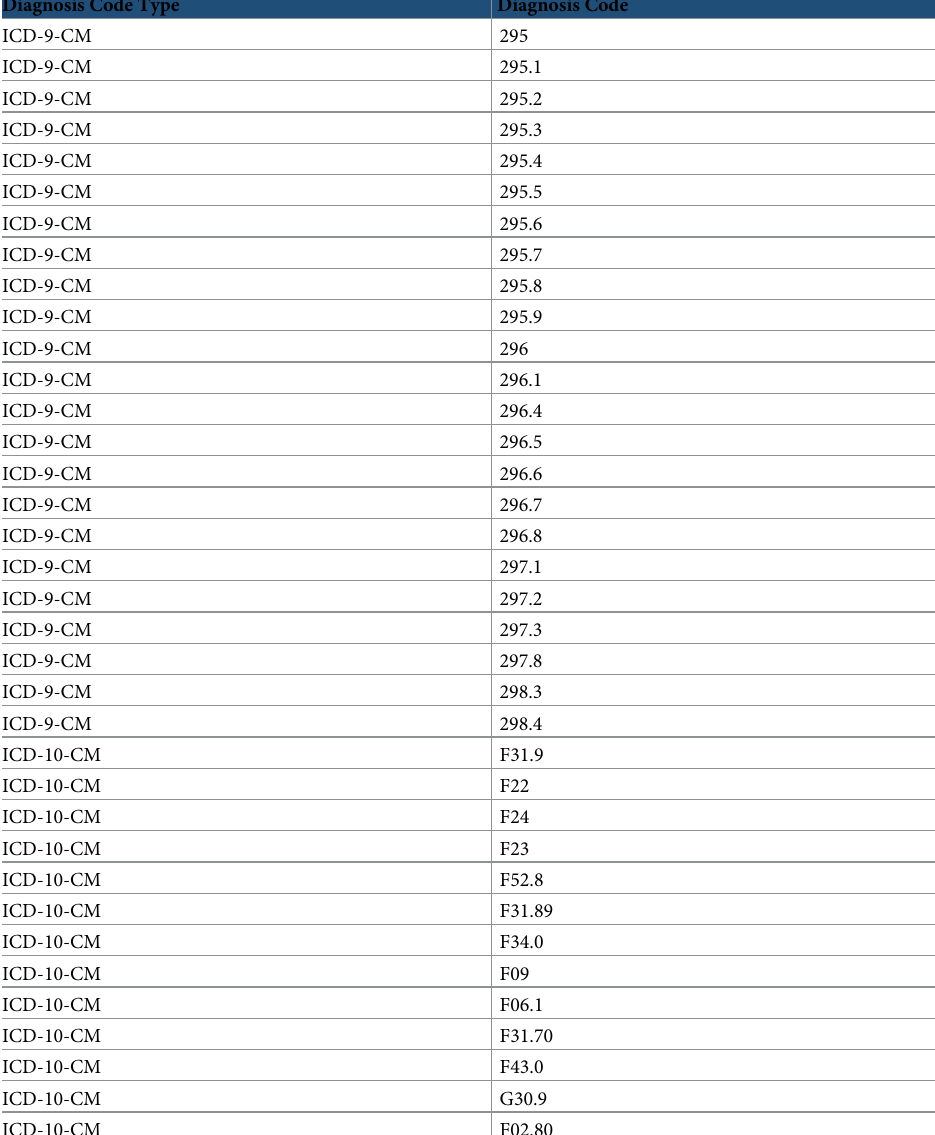
Table 2. ICD-9 and ICD-10 codes for exclusion criteria reflecting severe mental